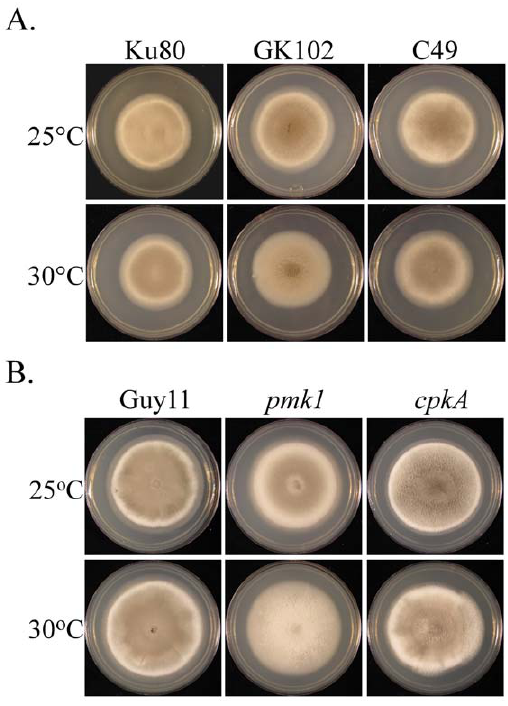
Figure 6. Increased heat sensitivity in the Mosfl1 and pmk1 mutants. A. Five-day-old CM cultures of Ku80, Mosfl1 mutant GK102, and complemented transformant C49. B. Seven-day-old CM cultures of the wild type Guy11, pmk1 mutant nn78, and cpkA mutant I-27. All of the cultures were incubated at 25 u C (top) or 30 u C (bottom). While the growth rates of Ku80 and Guy11 were not affected, the production of aerial hyphae was reduced in the Mosfl1 and pmk1 mutants when cultured at 30 u C.